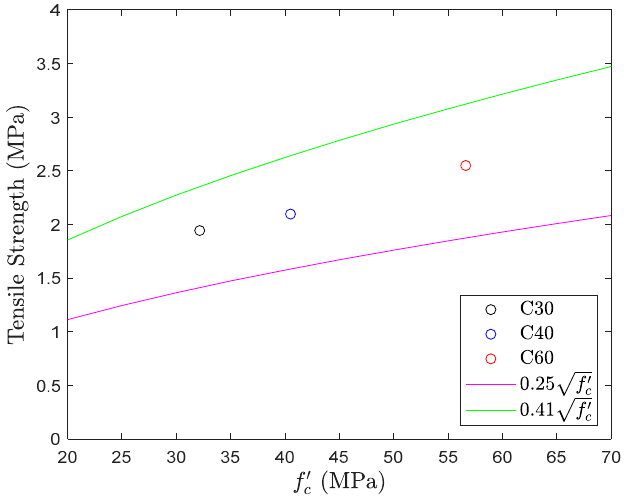
Figure 12. Tensile strength obtained from direct tension test.